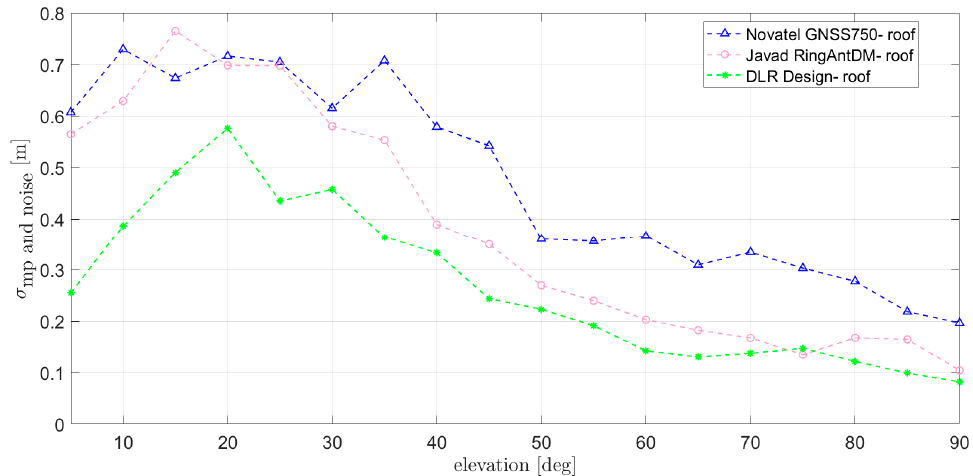
Figure 12. RMS of 100 s smoothed multipath (estimated through CMC) at L1/E1 for the antennas installed on the roof of DLR’s Institute of Communications and Navigation.